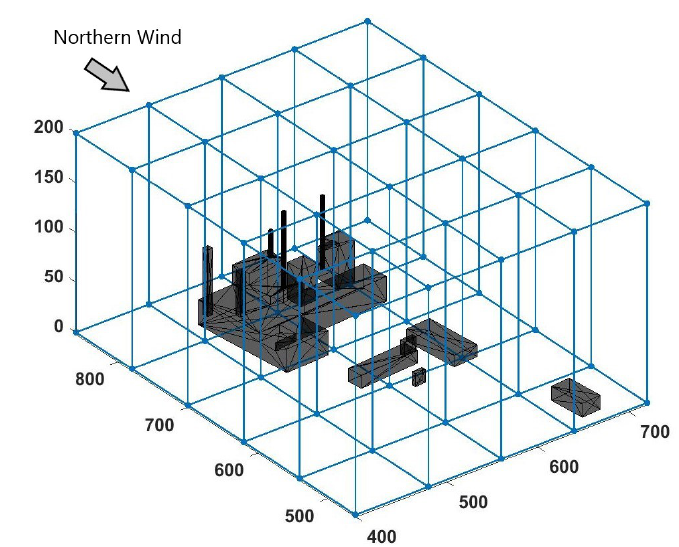
Figure 5. Simulation domain isometric view. The black structure is the representation of the present structure.